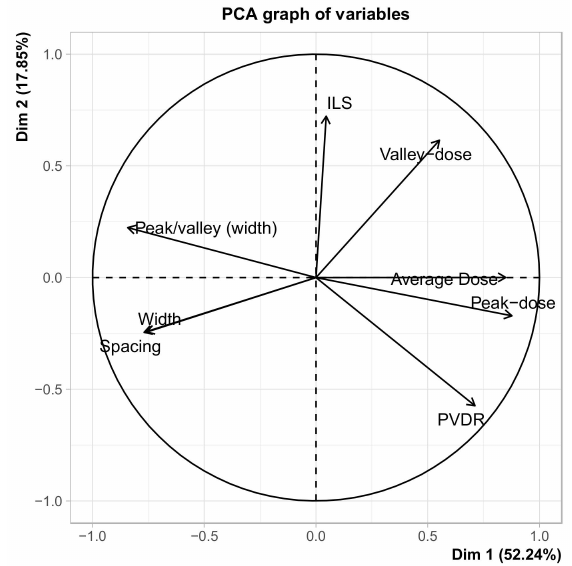
Figure 3. Principal component analysis (PCA) of all variables included in this preclinical SFRT study. Dimension or Component 1 (Dim1) accounts for 52.24% of the variance in the data and could represent dose deposition (dosimetry) as valley dose, average dose, peak dose, and PVDR have a positive effect on it. Dimension or Component 2 (Dim2) accounts for 17.85% of the variance in the data and could represent treatment outcome as ILS and valley dose have a positive influence on